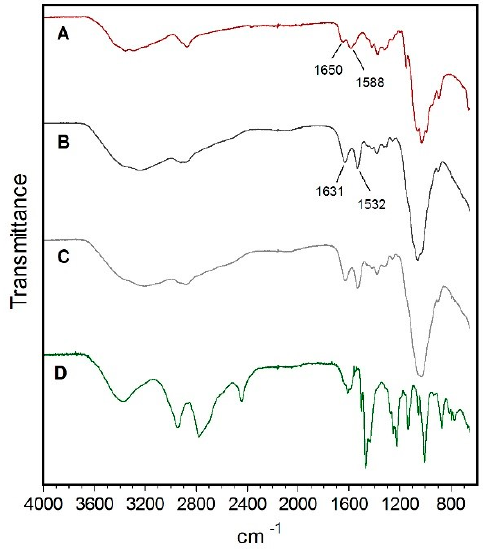
Figure 3. FTIR spectra of ( A ) Chitosan, ( B ) Chi NPs, ( C ) Chi-C48/80 NPs, and ( D ) C48/80.